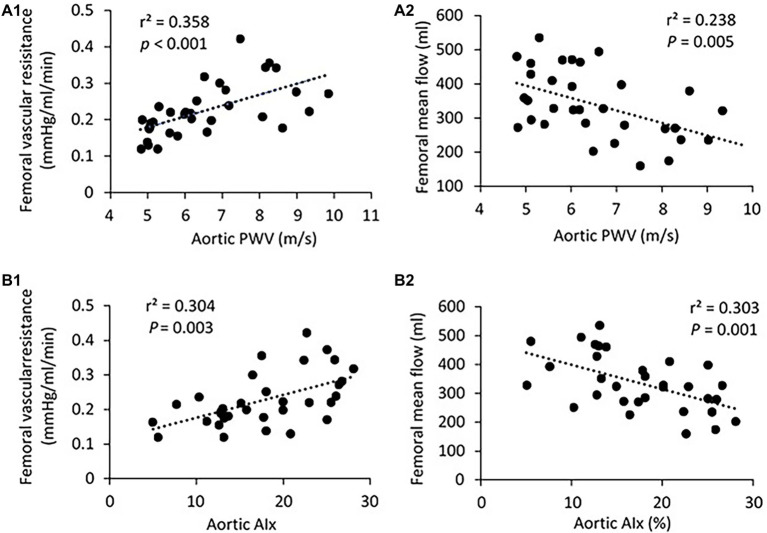
(A) Correlation of aortic PWV with femoral vascular resisitance (A1) and mean flow (A2). (B) Correlation of aortic AIx with femoral vascular resisitance (B1) and mean flow (B2). The linear regression analysis was conducted, and data are expressed as correlation coefficients and significance levels (r2; p).